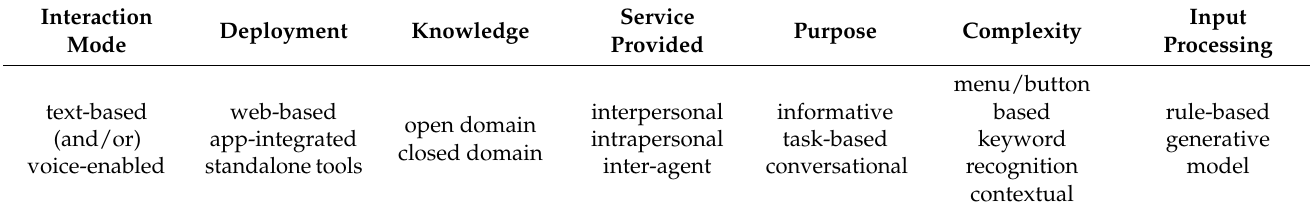
Table 1. Chatbot